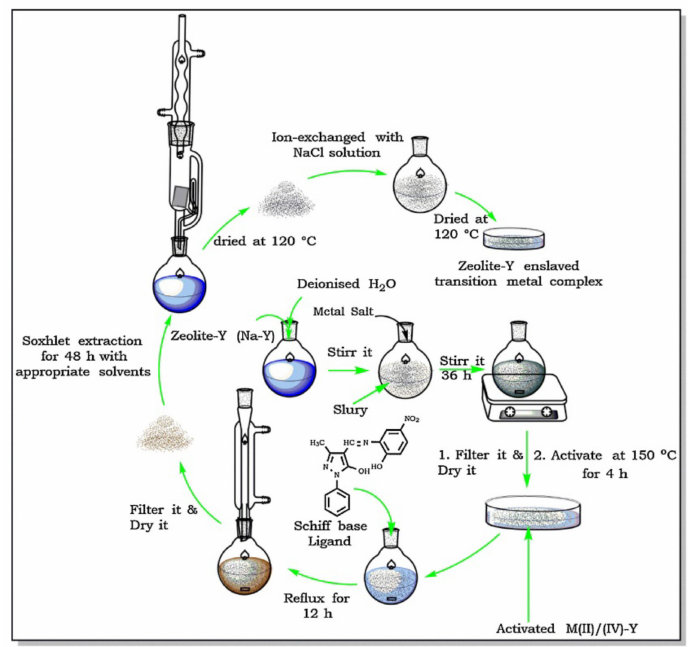
Figure 11. Scheme of the experimental procedure to encapsulate complexes on Y zeolite by flexible ligand method. Reproduced with permission from Reference [16] Copyright (2016) Elsevier B.